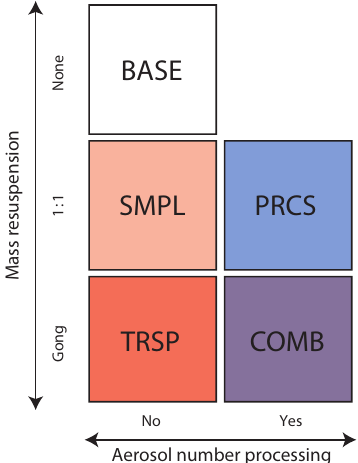
Figure 4. Overview of the simulations in this work. The position of the individual simulations indicates used choices for mass resuspen- sion and number processing of aerosols. Please note that the BASE simulation uses different meteorology as stated in the